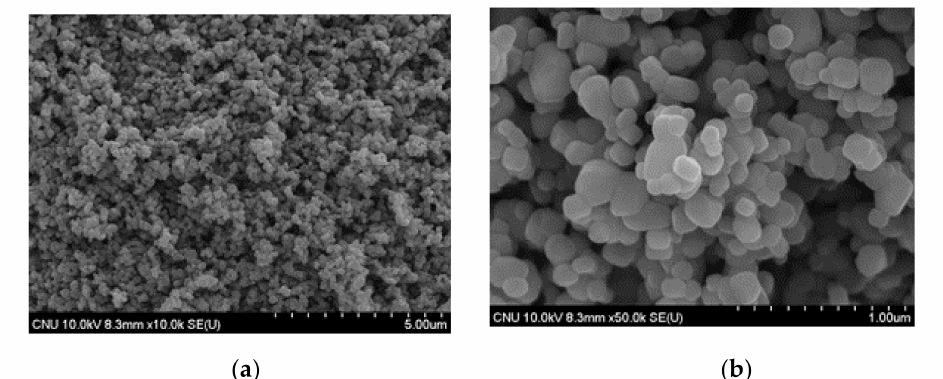
Figure 2. XRD pattern of NST.